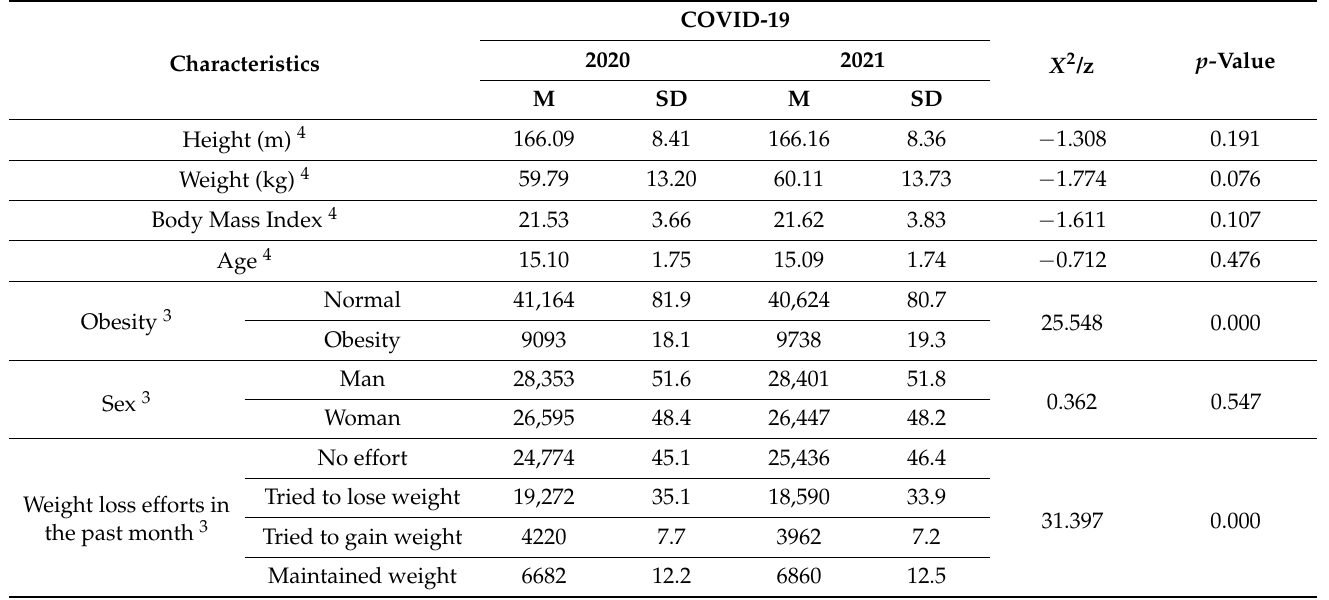
Table 1. Changes in general characteristics in the first and second years of the COVID-19 outbreak.